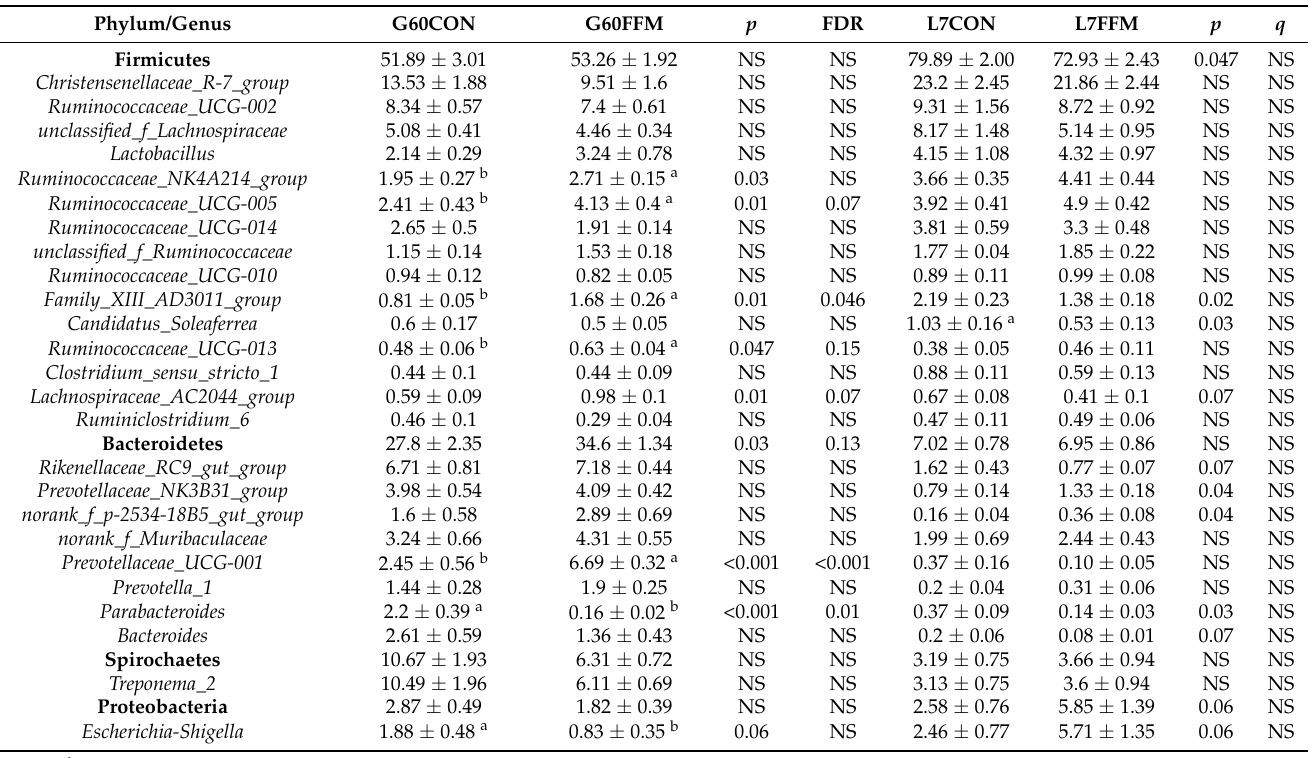
Table 3. Compositions of the fecal microbiota of sows on G60 and L7 at the phylum and genus levels. Phylum/Genus